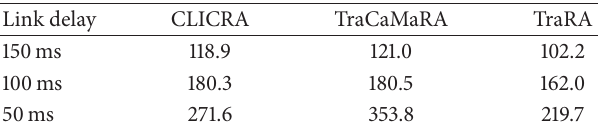
Table 7: Transmitted bytes (Gbytes) from the origin server to proxy